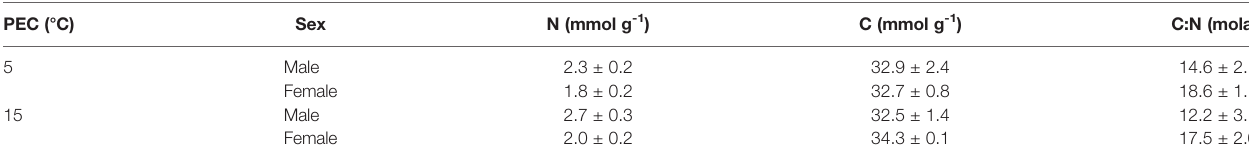
TABLE 1 | Molar concentration of nitrogen (N), carbon (C) and carbon: nitrogen ratio (C:N) of vegetative male and female gametophytes of Laminaria digitata kept in long-term pre-experimental cultivation (PEC) at 5°C and 15°C (mean ± standard deviation, n = 4). PEC (°C)